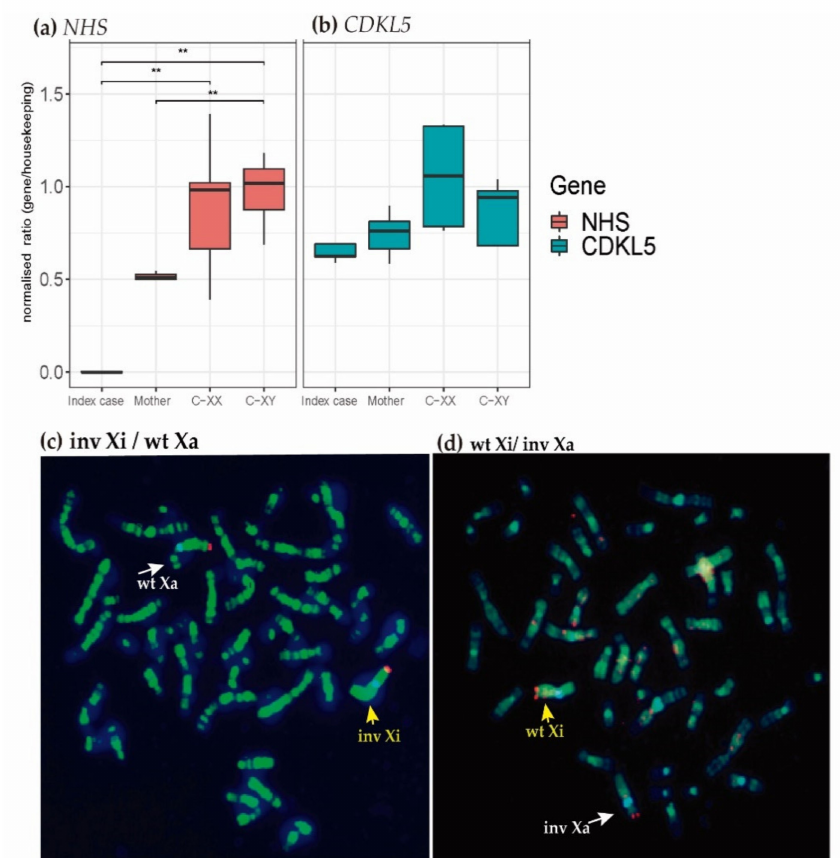
Figure 3. Functional characterisation of the inversion. ( a , b ) Boxplots represent the relative mRNA expression of NHS ( a ) and CDKL5 ( b ) in blood for the index case and his mother compared to 3 males and 4 females healthy controls. Expression of the housekeeping UB2DE2 gene was used for setting the relative expression. The experiment was performed in triplicates. Boxplot indicates median values and whiskers range of variation. ** = p < 0.01 (Wilcoxon test). C-XX: Female controls; C-XY: male controls. ( c – d ) X-chromosome inactivation pattern by EdU incorporation assay in lymphocyte cultures from the mother. X-chromosomes marked in total full green fluorescence reflect late replication associated with X-chromosome inactivation (yellow arrows). The X chromosome weakly banding labelled in green indicates active X-chromosomes (white arrows). Metaphases from the mother show: ( c ) inactive inverted X-chromosome (Inv-Xi) and active wild type X-chromosome (wt-Xa) and ( d ) inactive wild type X-chromosome (wt-Xi) and active inverted X-chromosome (Inv- Xa). Note: Edu incorporation was labelled with Alexa Fluor-488 and counterstained with DAPI. The X-centromeres were marked in blue in Cyan blue (CEPX probe) and the Xq telomeres in